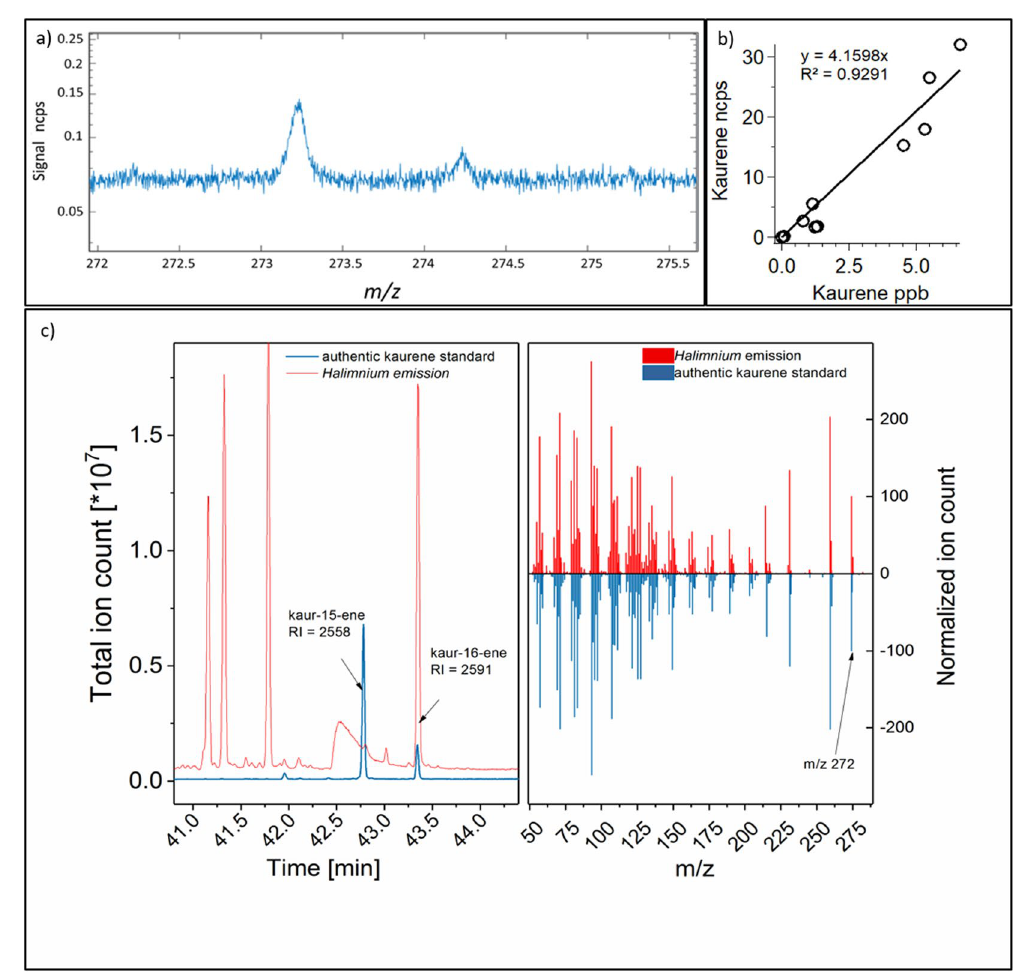
Figure 6. ( a ) Appearance of kaurene ( 12 C compound and its first isotopologue) in the TOF spectra in normalized counts per second; ( b ) calibration of kaurene for the PTR-TOF-MS of the sum of the 12 C compound and the first isotopologue in mixing ratio (ppb) against normalized counts per second; ( c ) the peak retention time for plant emissions (red) and standard (blue) kaurene for the TD-GC-MS (left panel), and comparison of TD-GC-MS fragmentation pattern for the plant emissions and standard of kaurene (right panel).